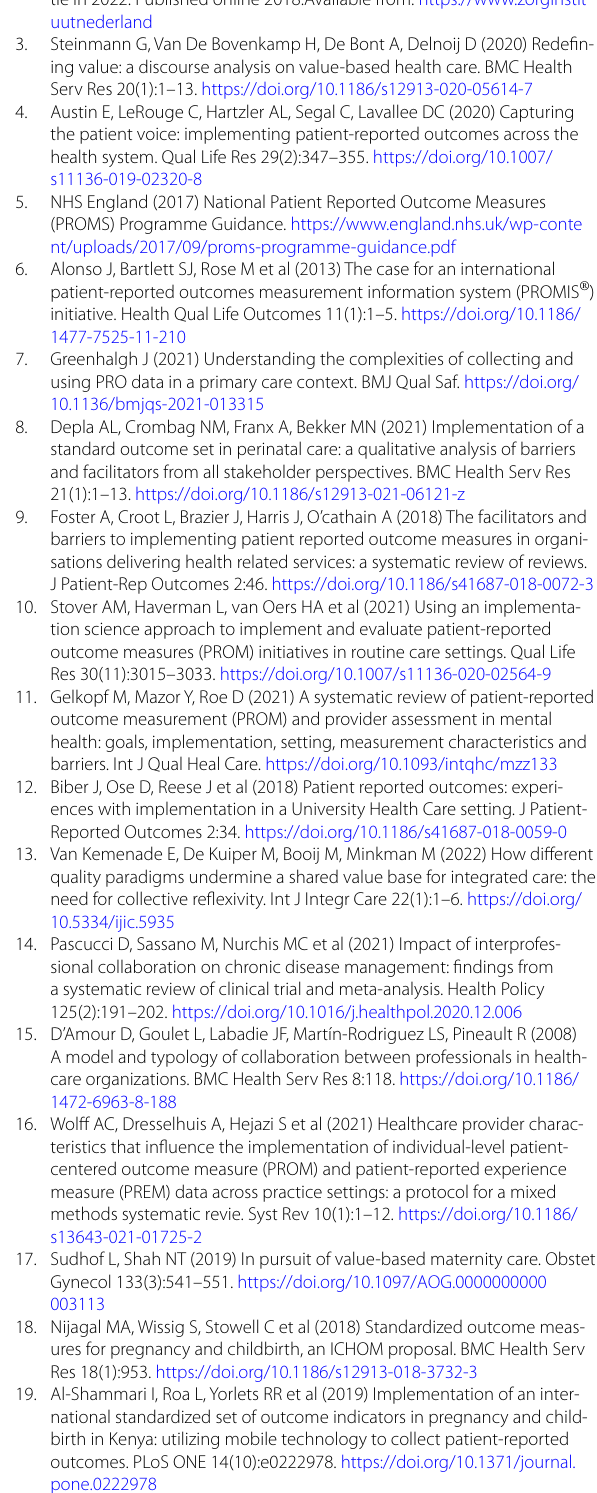
session. Figure S2 : Stacked‑bar graphs of survey